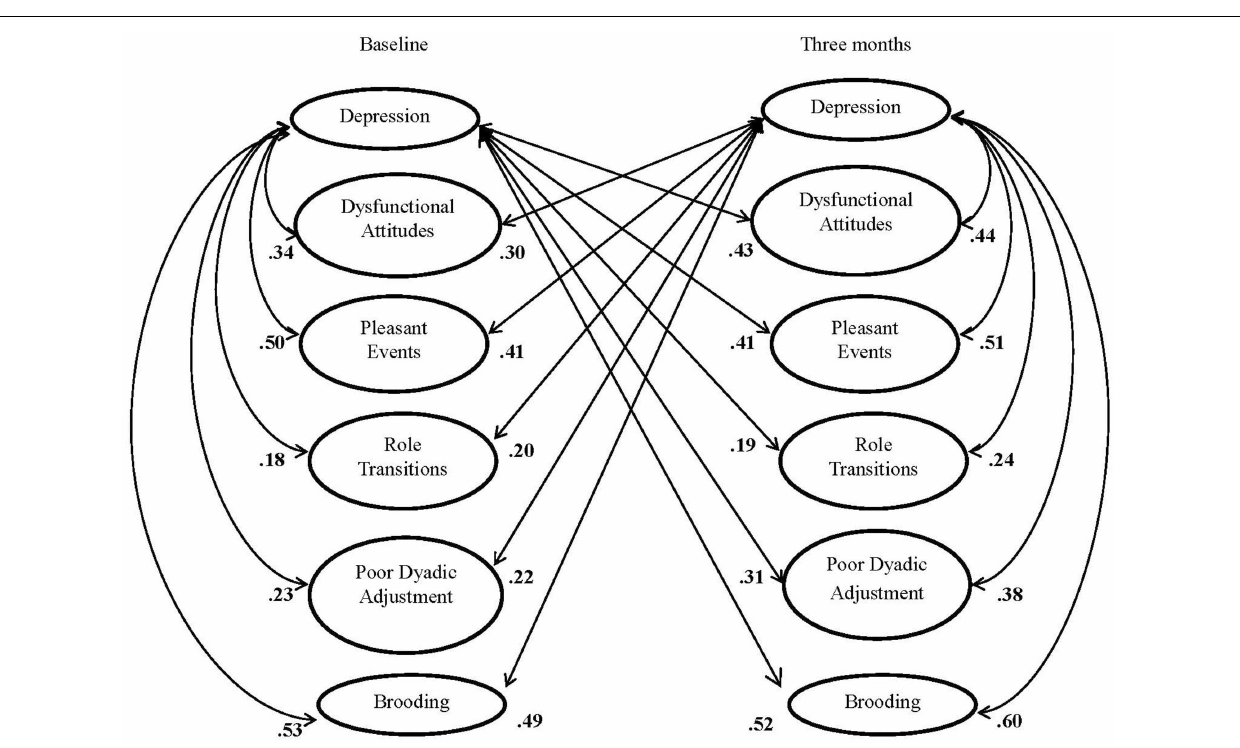
SUB-GROUP DIFFERENCES BETWEEN NON-DEPRESSED